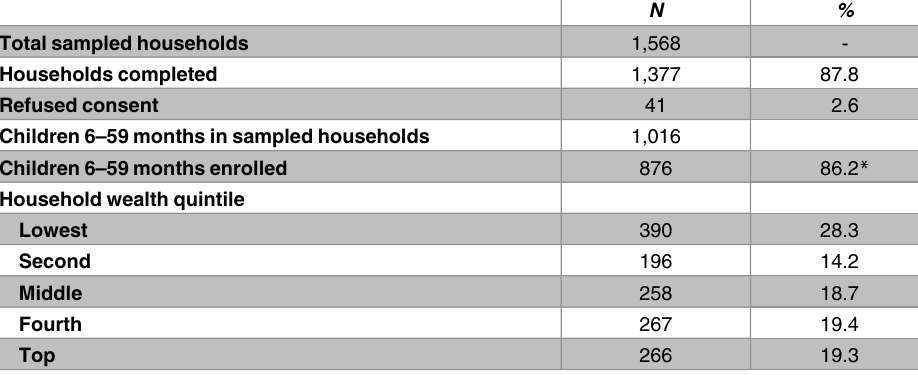
Top 266 19.3 * Percentage of eligible children from sampled households who actually took part in the survey.